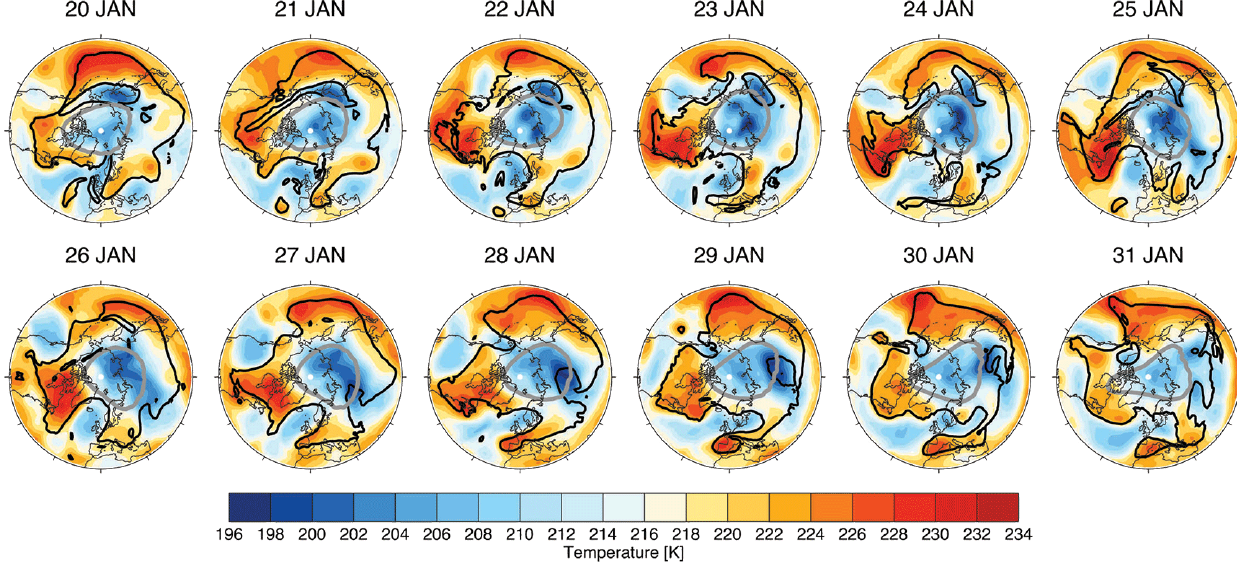
Fig. 15. Twelve day sequence of temperature at approximate tropopause level (315K isentropic surface) during the period when large reductions in the GOME-2 column ozone are observed (Fig. 13). The vortex edge is indicated by the gray contour of the 38 PVU potential vorticity at the 475K isentrope. The thick black contour denotes the 3 PVU potential vorticity at 315K, roughly separating polar air masses (low tropopause) from subtropical air masses (high tropopause). All data were obtained from the ECMWF ERA-Interim reanalysis.